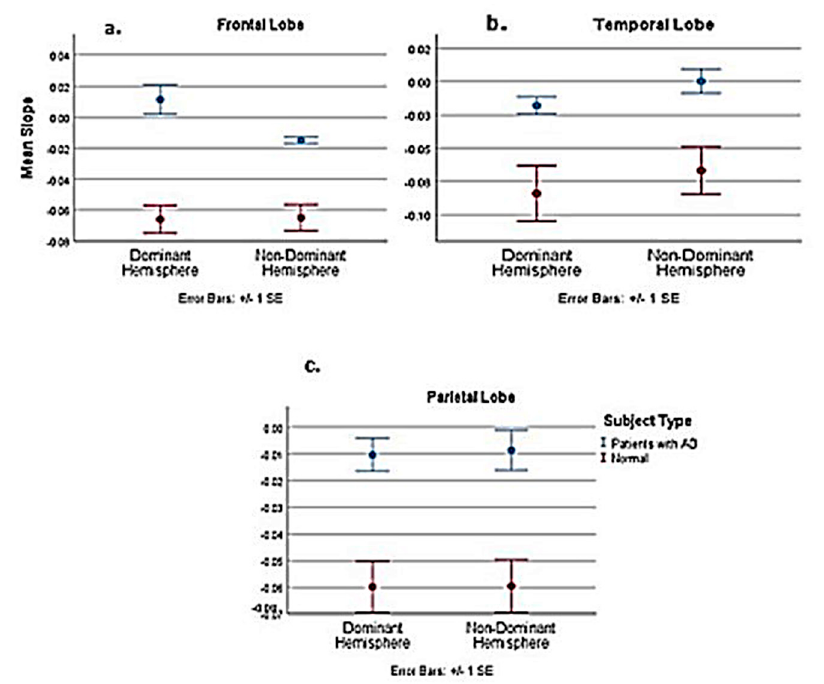
Figure A4. Slope comparison between pooled normal upper age group and AD subject